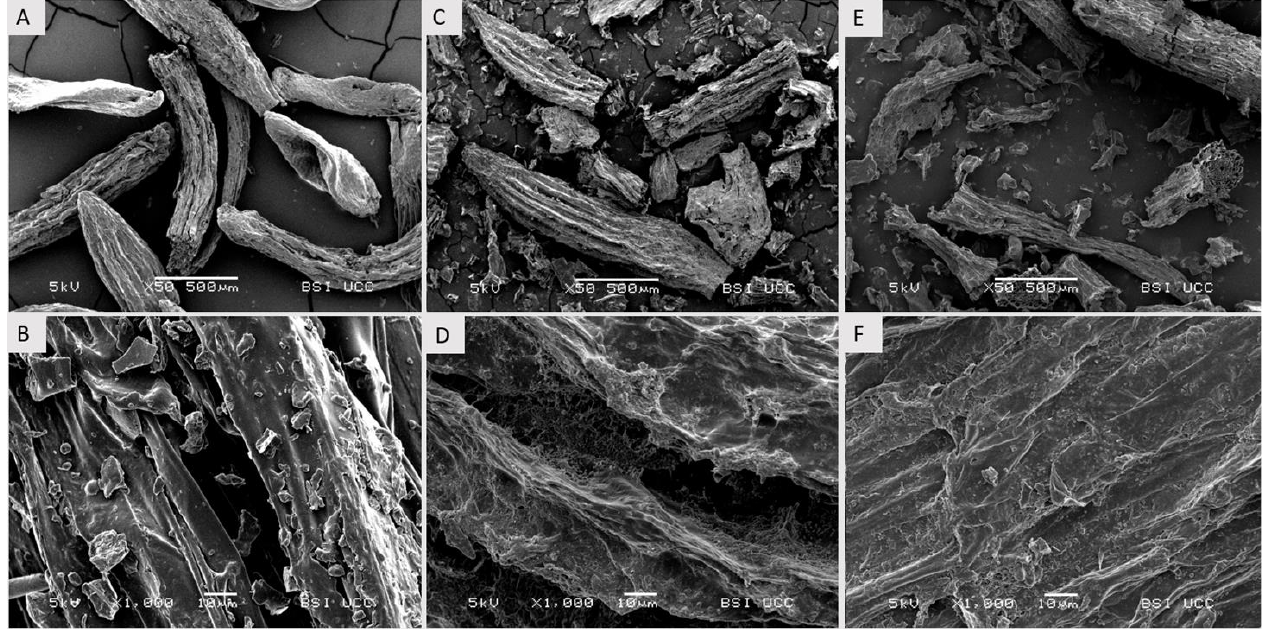
Figure 3. Scanning electron micrograph (SEM) of unfermented rootlets ( A , B ), sterilised rootlets ( C , D ) and rootlets fermented with Limosilactobacillus reuteri R29 ( E , F ) at magnifications of ×50 ( A , C , E ) and ×1000 ( B , D , F ).